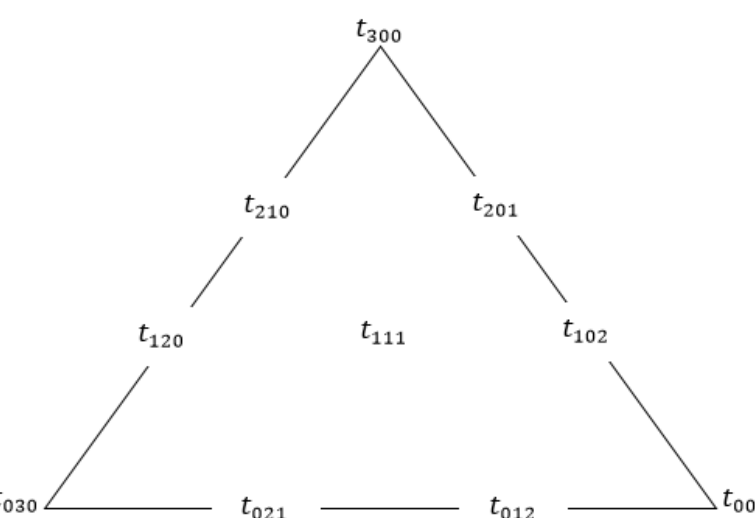
Figure 2. Control nets for cubic Timmer triangular patch.